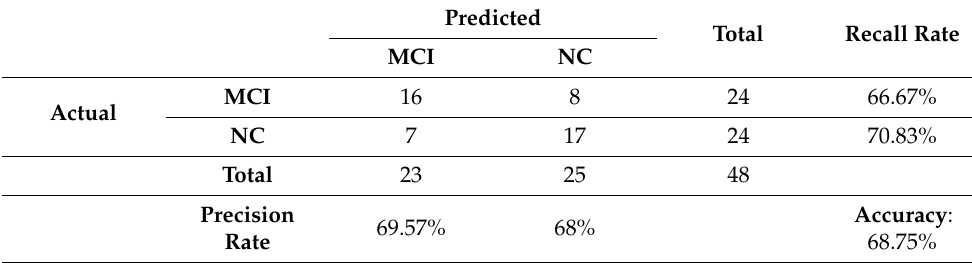
Table 7. Confusion Matrix with Precision and Recall rates using HRV only.